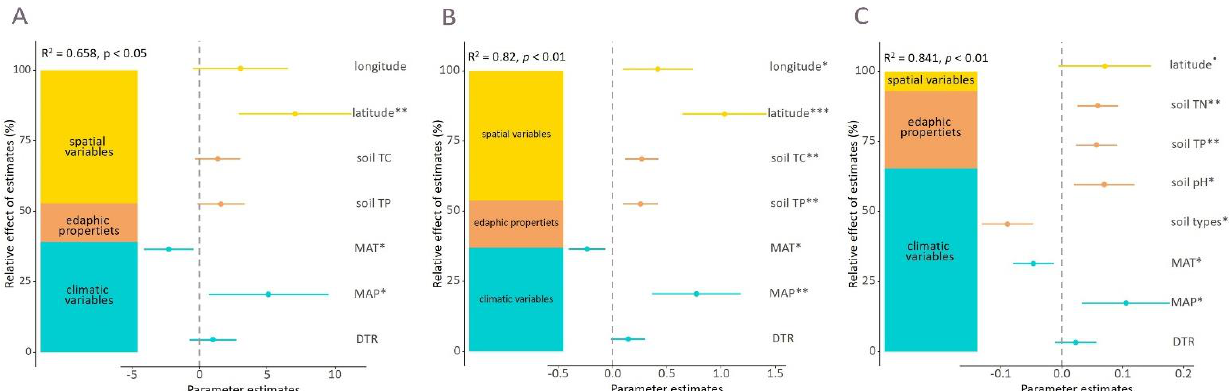
Figure 3. Effect of geospatial and environmental predictors on the taxonomic alpha diversity: richness ( A ), Shannon–Wiener index ( B ), and Pielou’s evenness ( C ). For each of the three indices, the average parameter estimates (standardized regression coefficients) of model predictors are presented on the left panels, and the associated 95% confidence intervals and relative importance of each factor are presented on the right panels. The relative contributions of each group of predictors are expressed as the percentage of explained variance. The p value of each predictor is given as: . p < 0.1; * p < 0.05; ** p <